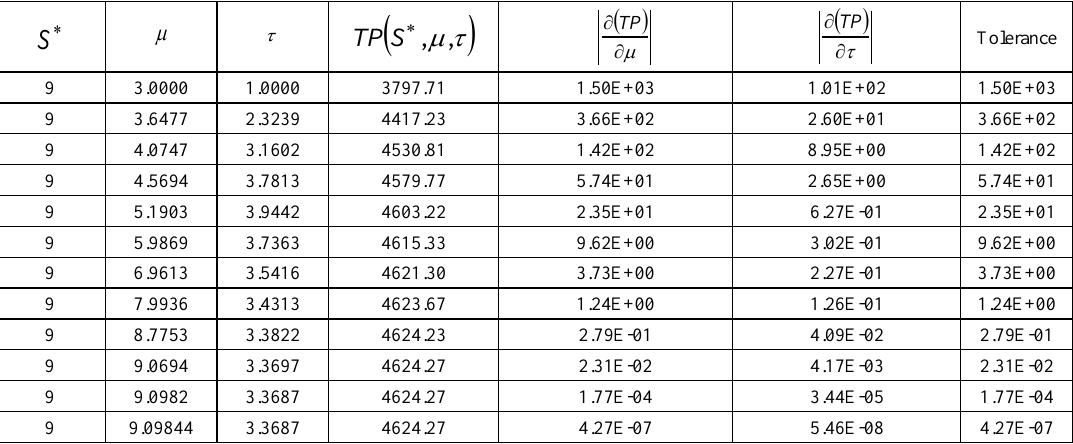
Table 9. An illustrative example of the Newton-quasi method.